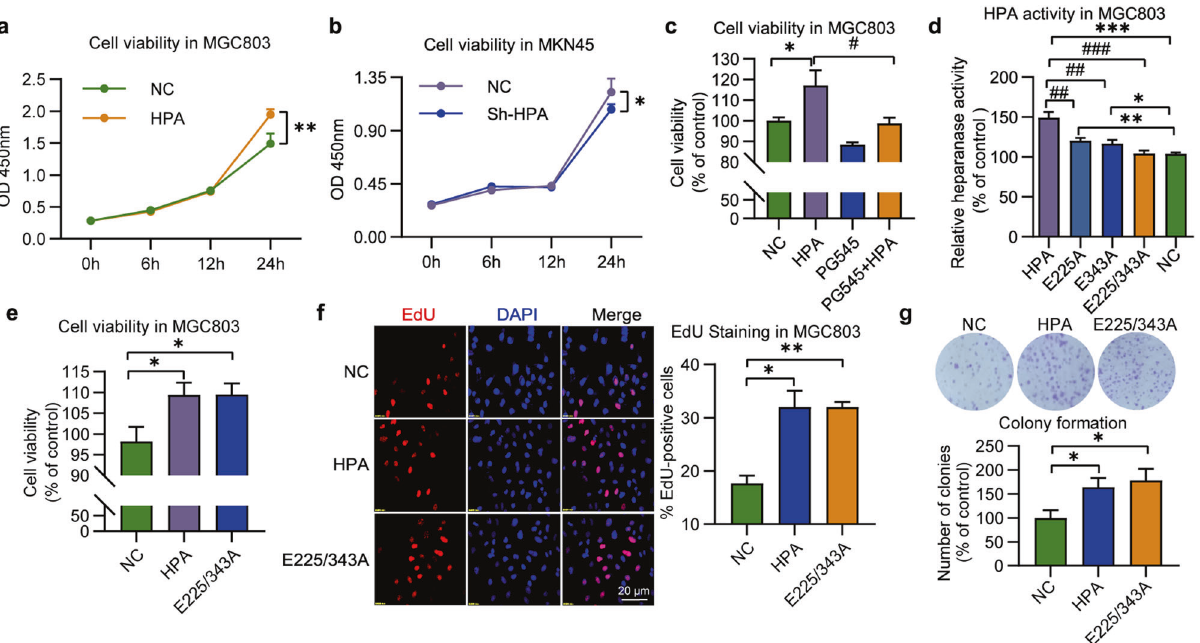
Fig. 1 Nonenzymatic HPA induces cell proliferation in gastric cancer cells. Proliferation of HPA-overexpressing MGC803 cells ( a ) and HPA- knockdown MKN45 cells ( b ). c Effect of PG545 on the proliferation of HPA-overexpressing MGC803 cells. d HPA enzymatic activity in MGC803 cells after transfection with active or inactive HPA. Cell viability ( e ) and EdU staining ( f ) and colony formation ( g ) of MGC803 cells overexpressing active or inactive HPA. * P < 0.05, ** P < 0.01, *** P < 0.001 versus the NC group, # P < 0.05, ## P < 0.01, ### P < 0.001 versus the HPA